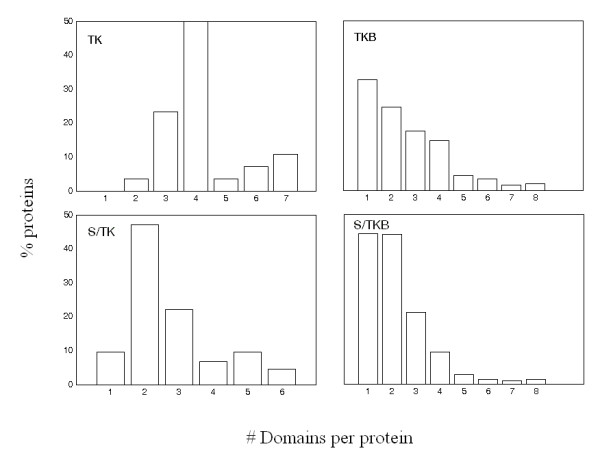
Domain number density for kinases and their substrates. Percentage of kinases (substrates) with N domains, N = 1, 2, 3,...,8. The symbols TK and S/TK identify tyrosine and serine threonine kinases, respectively. TKB and S/TKB are their substrates.